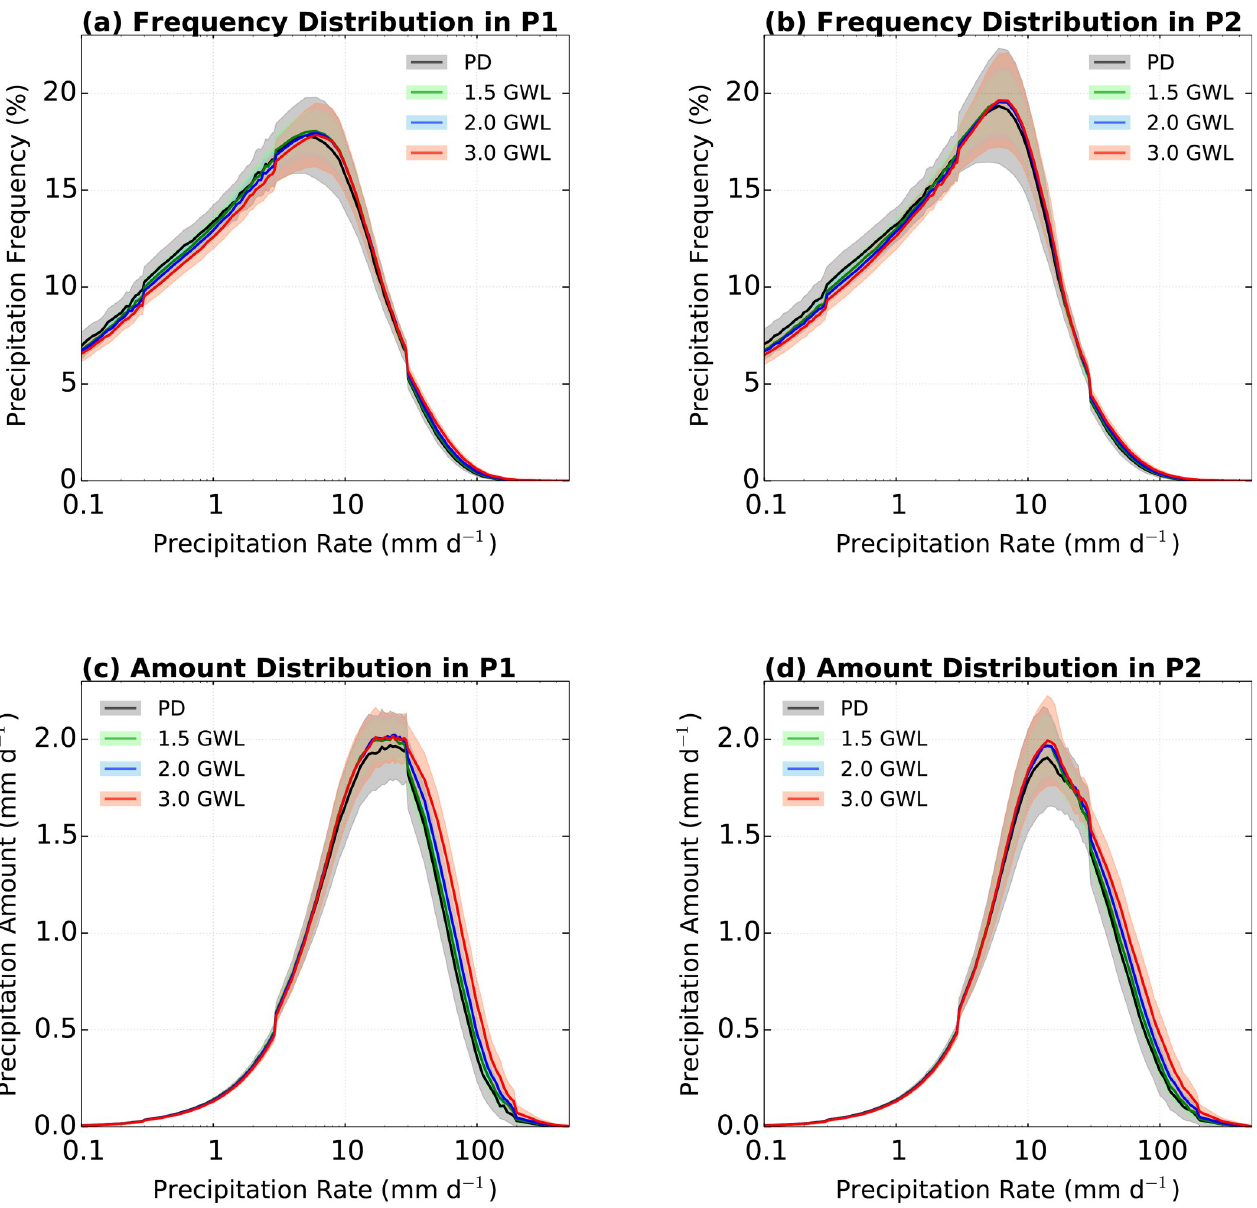
Fig 9. Daily precipitation over the EA domain for distributions of (a, b) precipitation frequency (%) and (c, d) precipitation amount (mm d − 1 ). The left and right columns indicate respective distributions in P1 and P2. The black, green, blue, and red lines indicate the PD period, 1.5, 2.0, and 3.0˚C global warming periods, respectively. The shadings are 95% confidence in the CMIP6